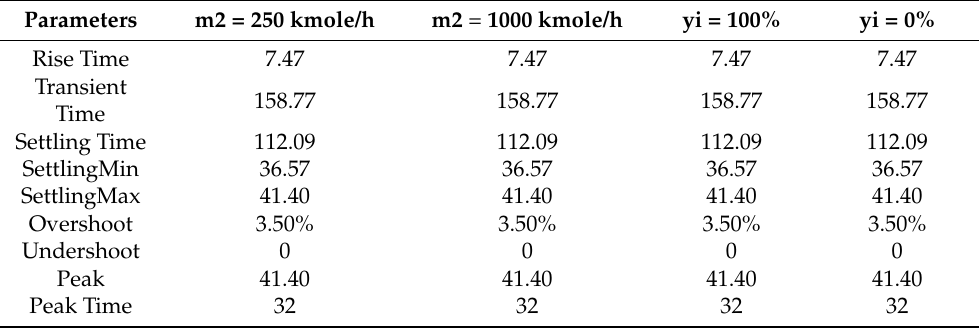
Figure 15. Response of system with reinforcement learning as controller in the case of several values of m2 and yi: ( a ) decrease m2 to 250 kmole/h; ( b ) increase m2 to 1000 kmole/h; ( c ) increase yi to 100%; ( d ) decrease yi to 0%. Table 5. Step-response characteristics for system in Figure